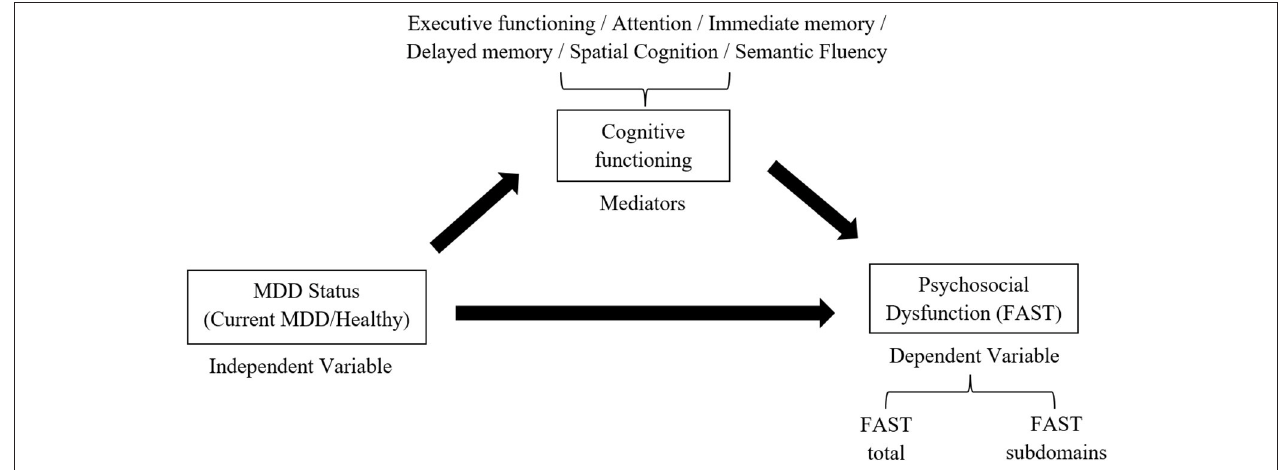
FIGURE 1 | Proposed mediation relationship between MDD status (Current MDD, HCs), cognitive functioning, and psychosocial dysfunction.